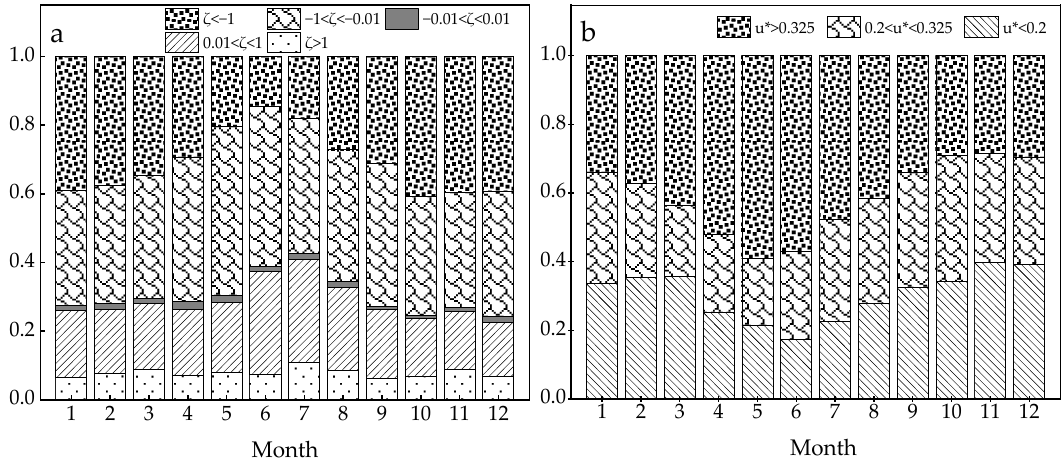
Figure 3. Cumulative frequency stack plots for the study period, ( a ) atmospheric stability, classified into the following five categories: very unstable ( ζ < − 1), unstable ( − 1 < ζ < − 0.01), neutral ( − 0.01 < ζ < 0.01), stable (0.01 < ζ < 1), and very stable ( ζ > 1); ( b ) frictional velocity.